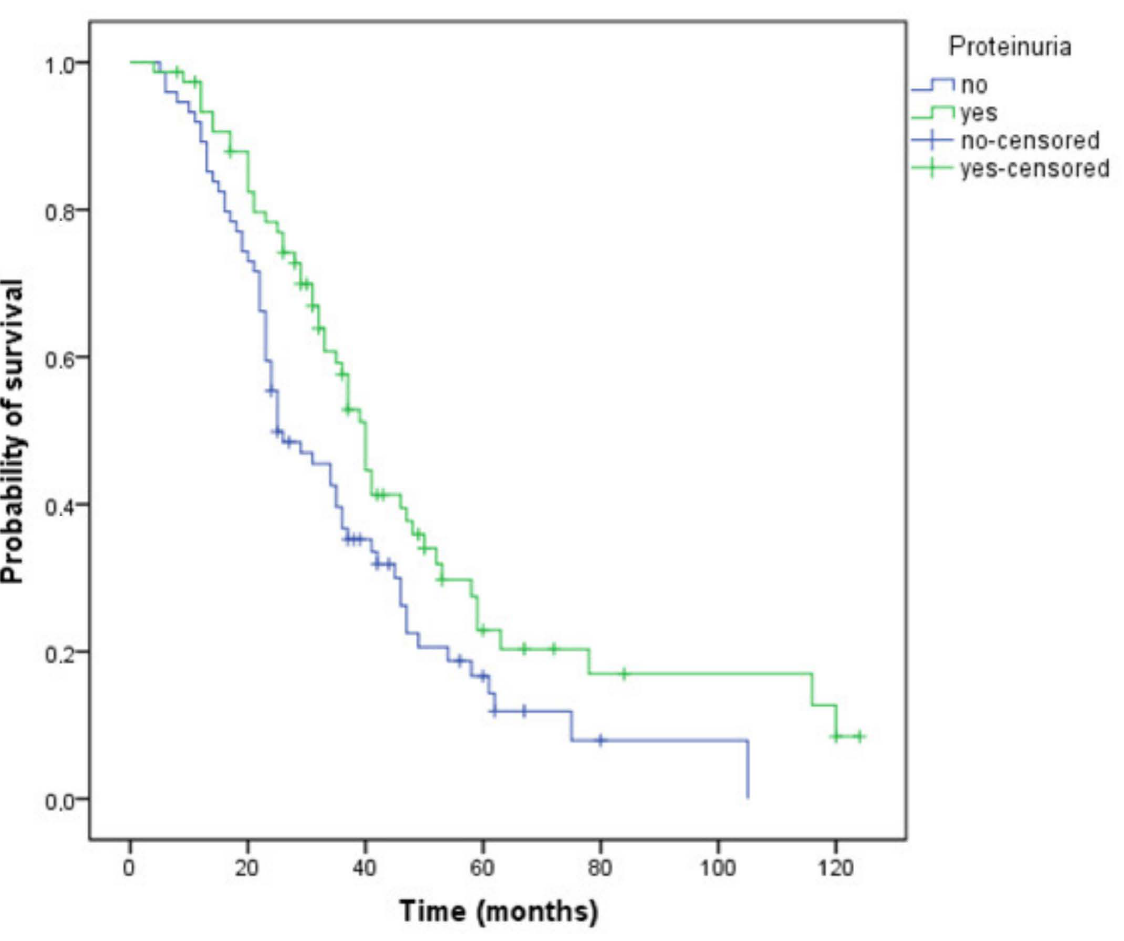
Figure 2. Kaplan–Meier curve of overall survival for patients who have or have not developed proteinuria during treatment (OS, 40 versus 25 months, p =